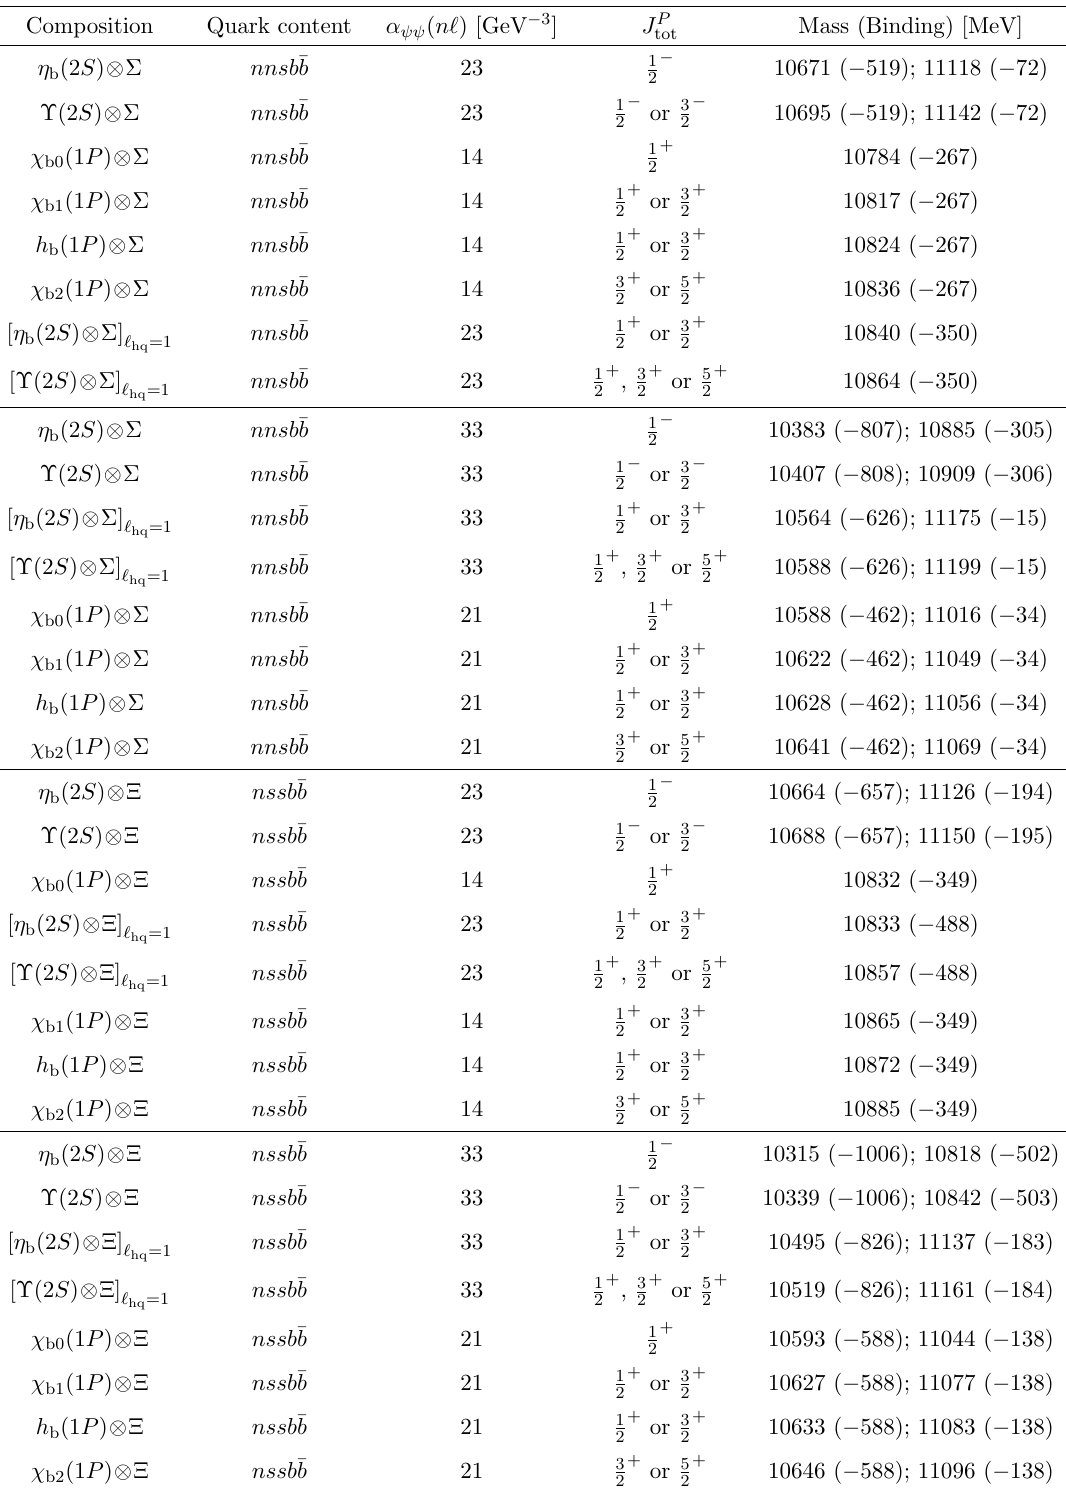
Table 3 . As table 2, but for bottomonium-(cid:6) and (cid:4) bound states.